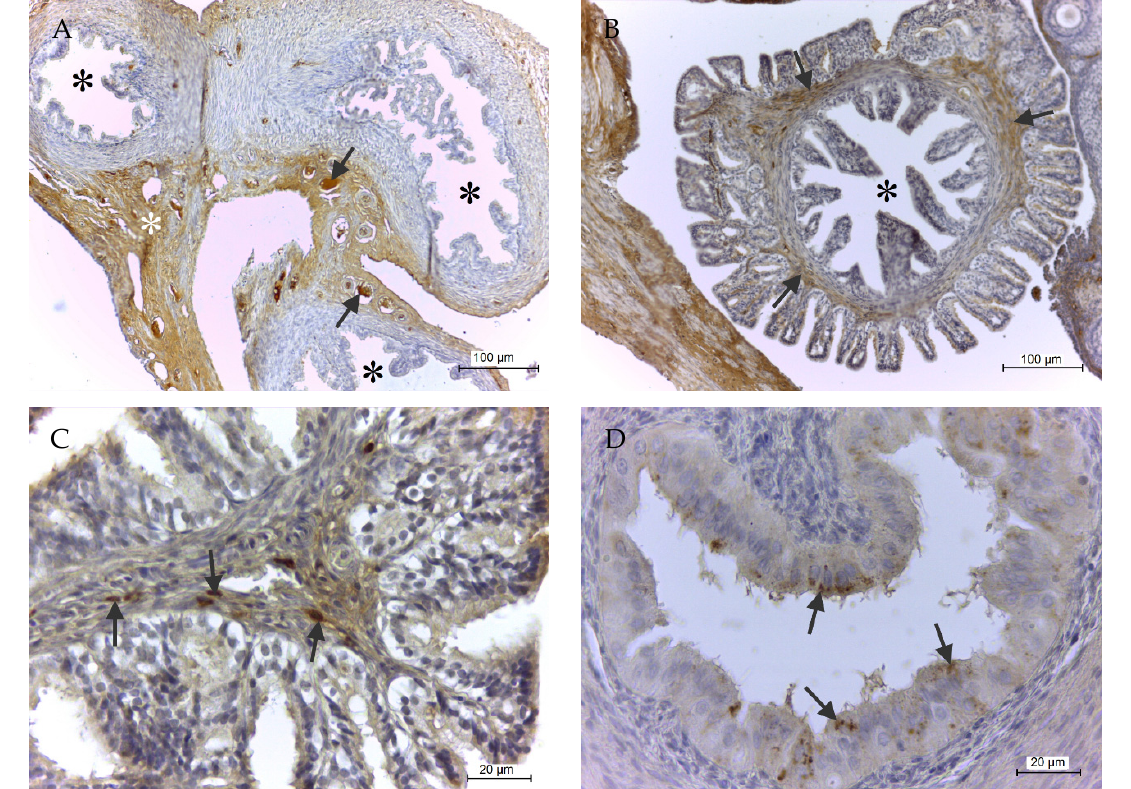
Figure 3. GPx8 presence in rat oviduct. ( A ) represents the overall view of protein presence, where the enzyme was predominantly seen in plasma in blood vessels (arrows) and extracellular matrix of fibrous tissue under the serous membrane (white asterisk). ( B ) shows protein presence in the infundibulum of the uterine tube (arrows). Black asterisks in ( A , B ) represent tubal lumen. ( C ) shows in detail that the enzyme in infundibulum was located in spindle-shaped fibroblasts (arrows). ( D ) shows the isthmic part of the uterine tube where the enzyme was present as granules in epithelial